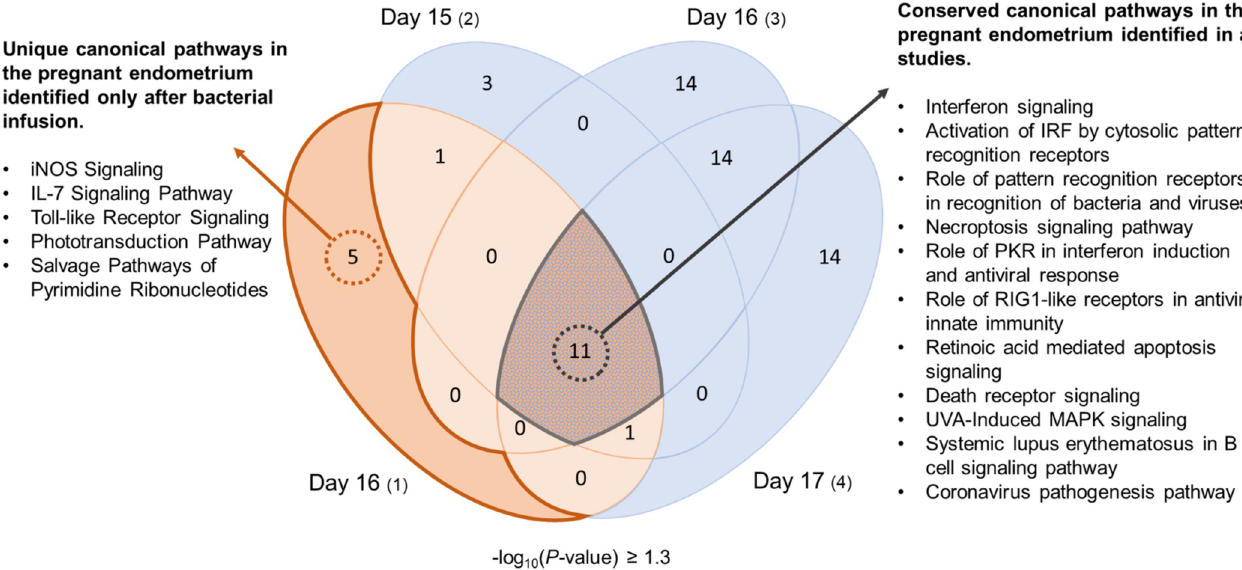
Fig 4. Pregnancy regulated canonical pathways in the endometrium of healthy cows and cows following intrauterine infusion of pathogenic bacteria.